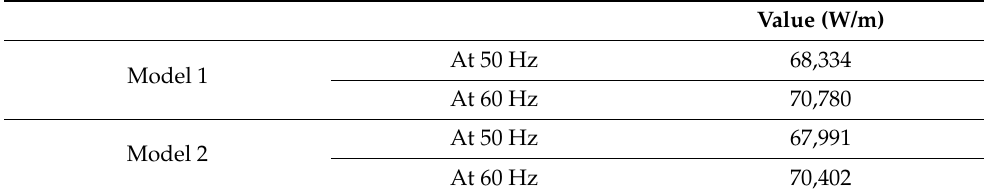
Figure 3. Magnetic flux density at 60 Hz for: ( a ) Model 1; ( b ) Model 2. Table 5. Electromagnetic heating (losses) for singular busbar system